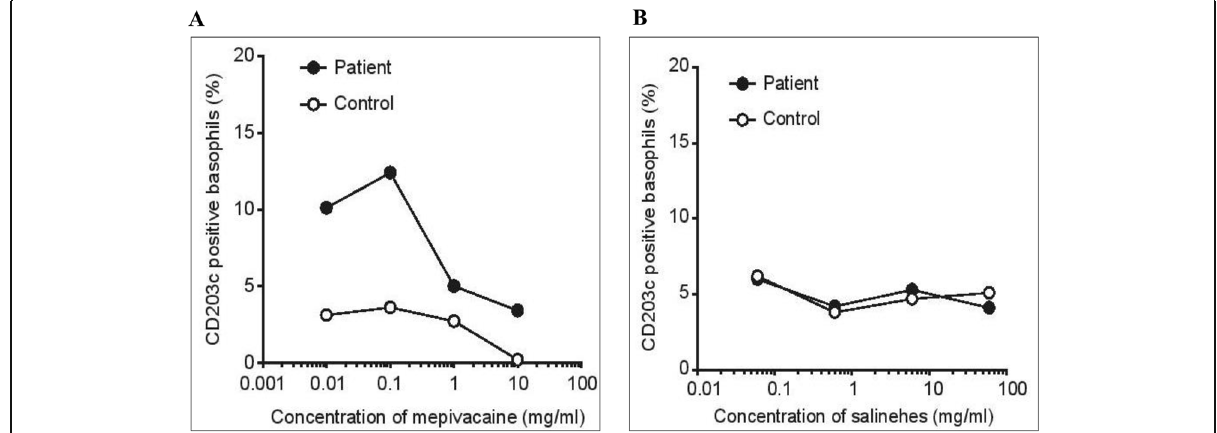
Fig. 1 Basophil activation test. Flow cytometric analysis of basophils expressing CD203c. a The patient ’ s mepivacaine-induced CD203c upregulation. b Hydroxyethylated starch did not induce CD203c